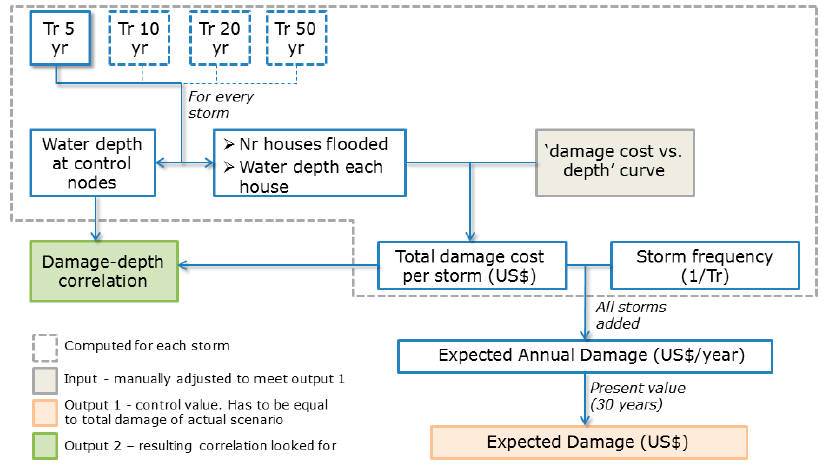
Figure 2. Process for deriving the depth–damage correlation. The depth–damage correlation links the total damage in the catchment to water level in a selected (1-D) model-node.